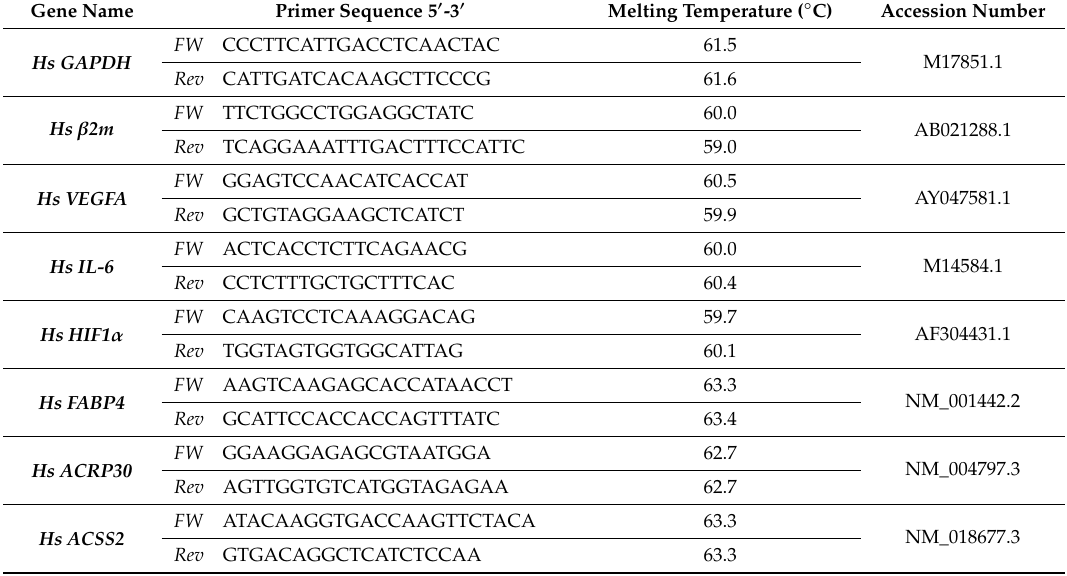
Table 1. Primers used in this work. FW = Forward primer; Rev = Reverse primer.